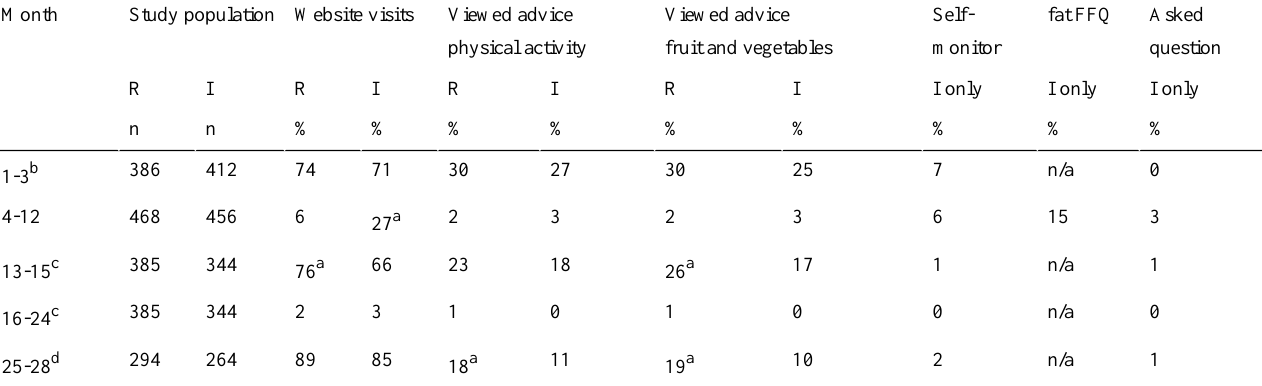
Table 3. Website visits and use of different website functionalities throughout the study in the reference (R) and intervention (I) program.